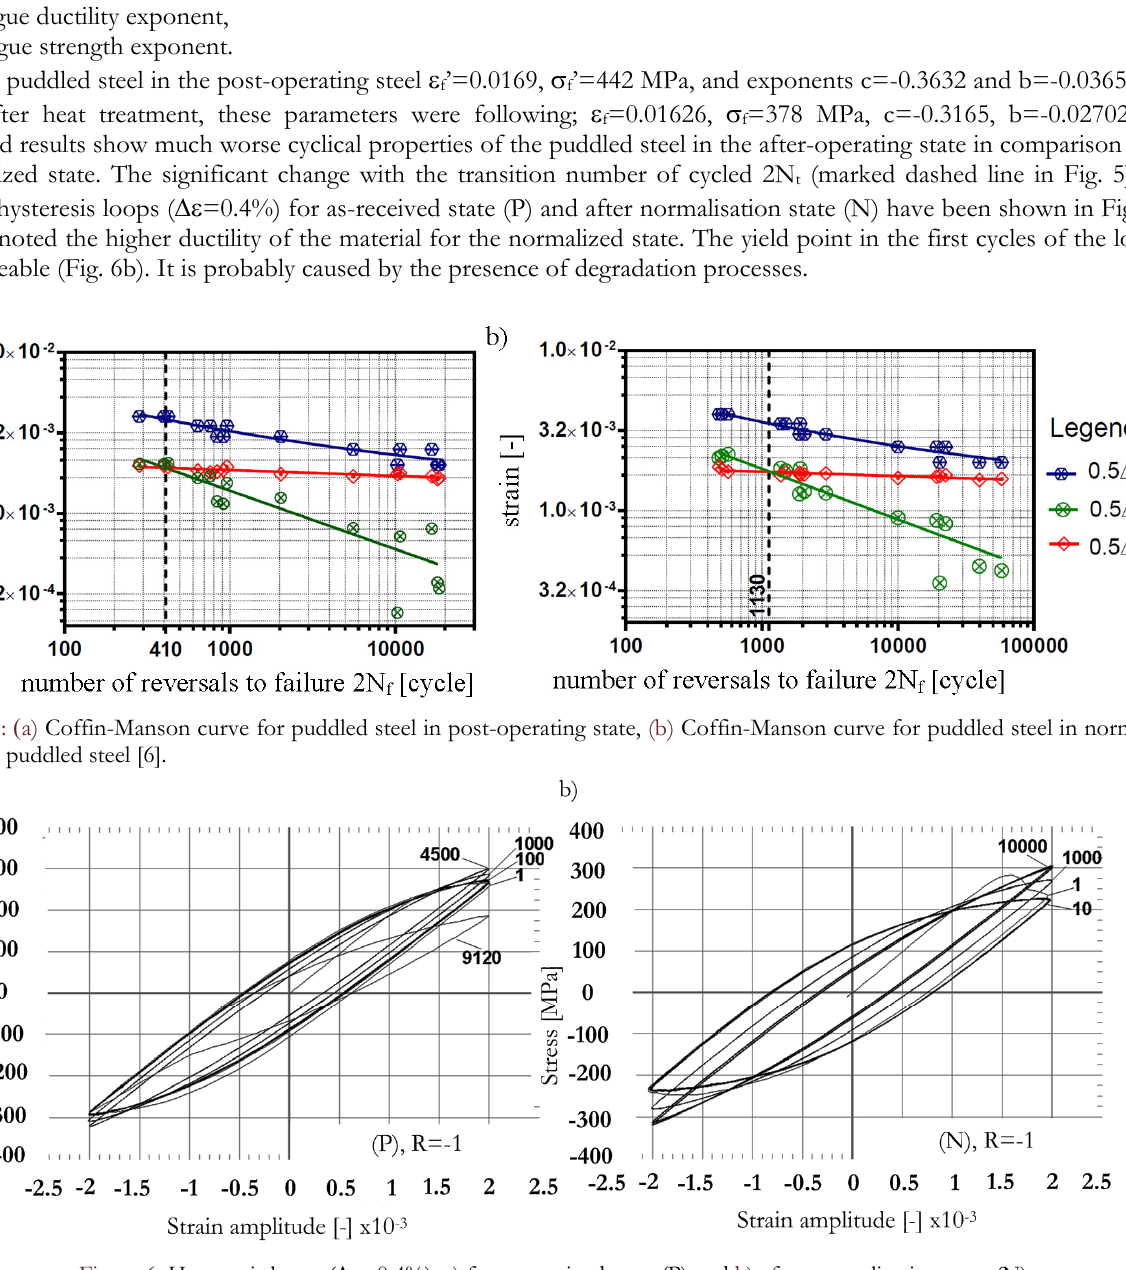
Figure 6: Hysteresis loops (  =0.4%), a) for as-received state (P) and b) after normalization state